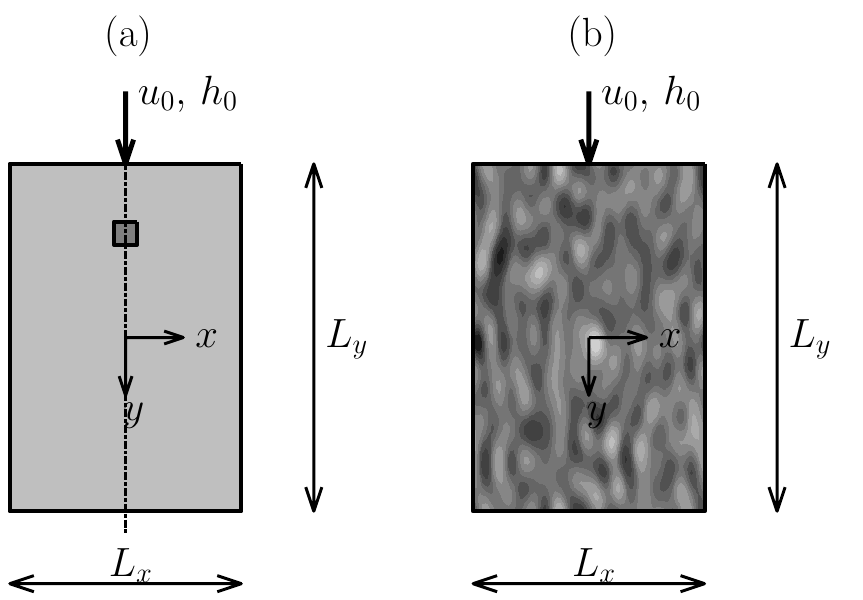
Figure 1. Investigated hybrid configurations: single array of equally spaced contamination spots ( a ); draft of the hybrid surface characterized by randomly distributed contamination spots ( b